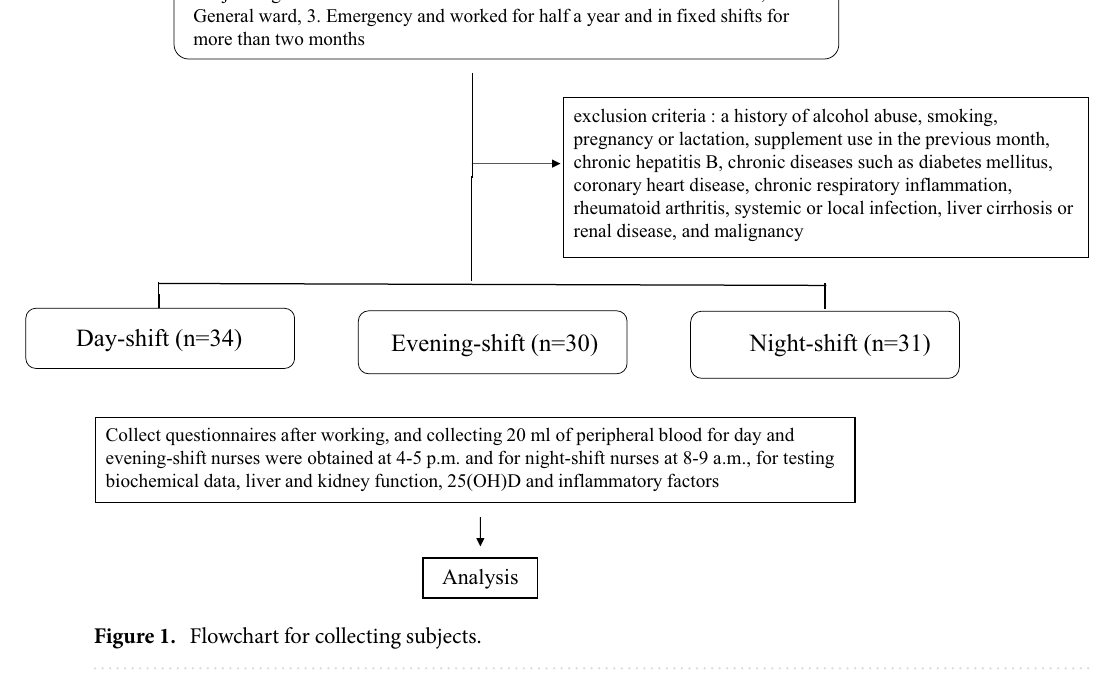
Figure 1. Flowchart for collecting